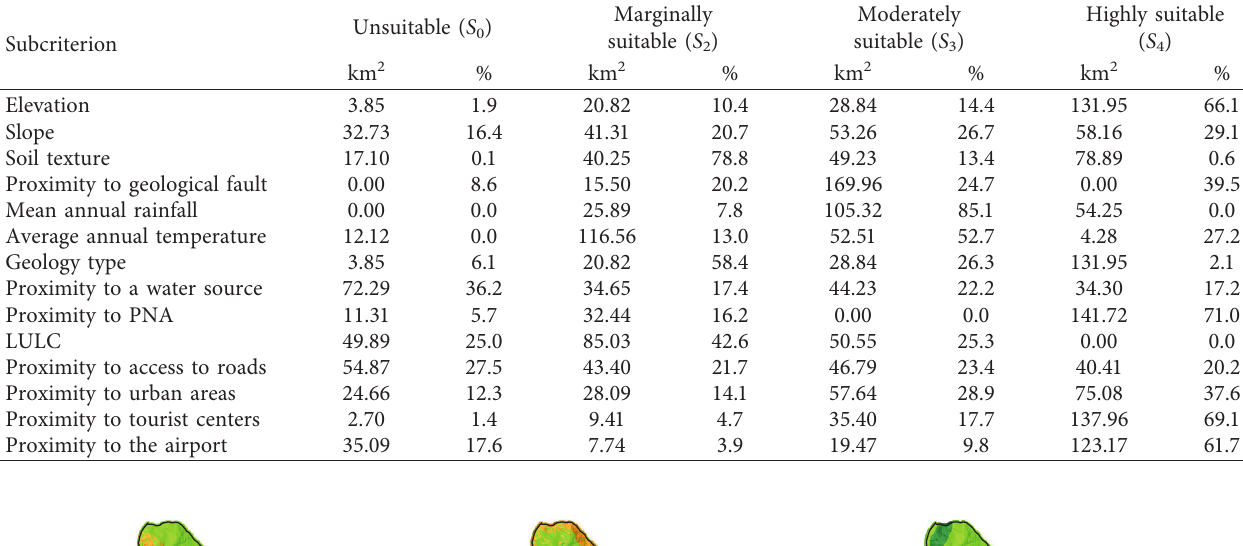
Table 6: Areas according to suitability levels for each subcriterion for the analysis of the suitability of potential landfill sites in Chachapoyas and Huancas, NW Peru.